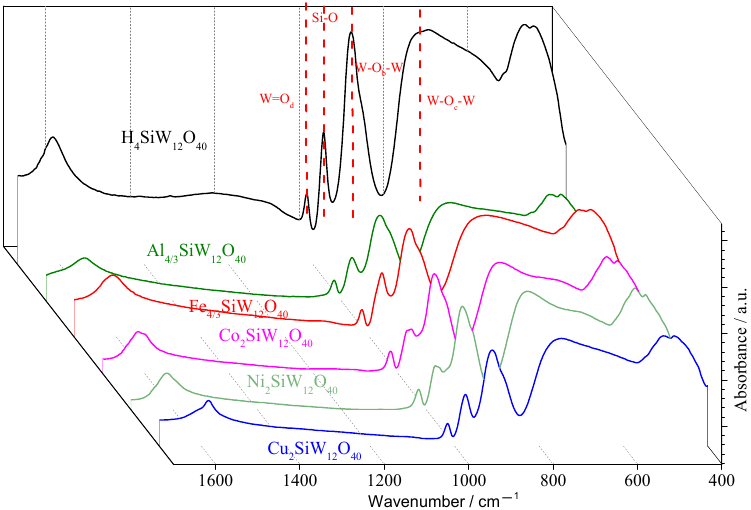
Figure 2. Infrared spectra of metal-exchanged silicotungstic acid salts (adapted from ref.